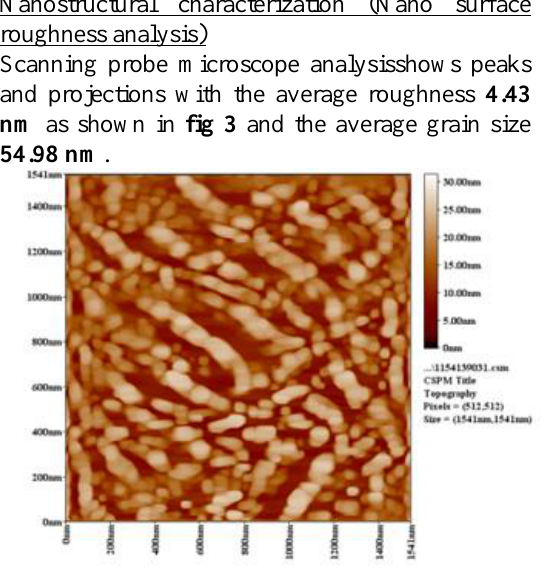
Figure 3: Average nano surface roughness of Al O and AgNO coated CpTi dental 2 3 3 implant.